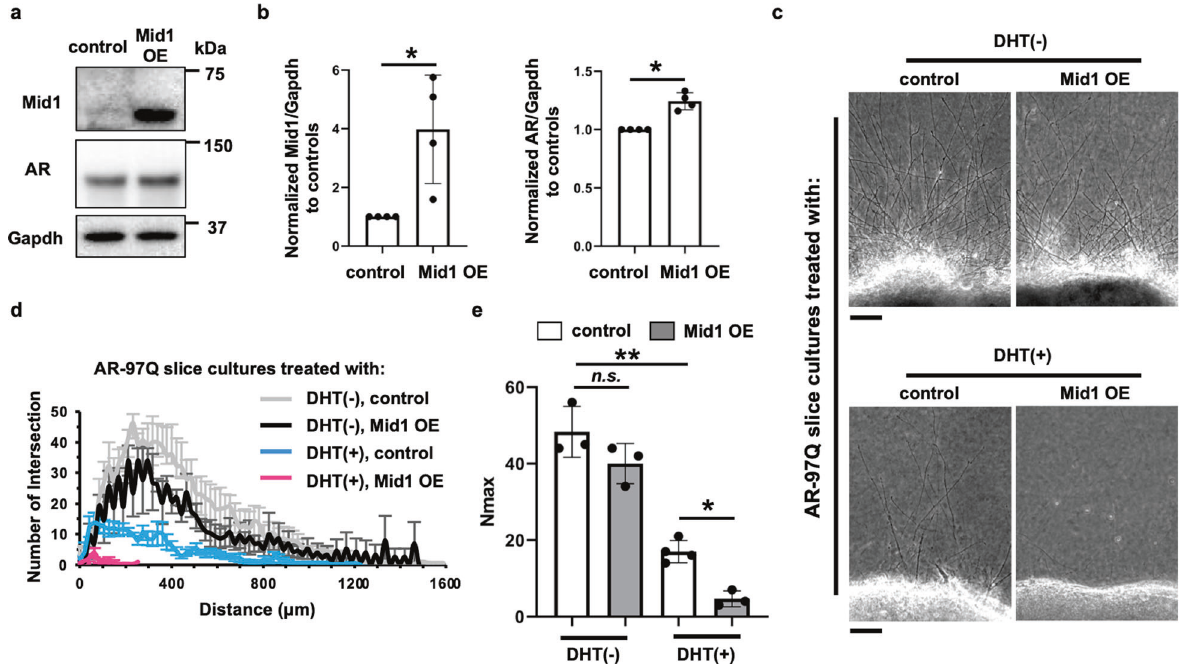
Fig. 6 Exacerbation of axonogenesis impairment by Mid1 overexpression in SBMA. a Immunoblots showing levels of Mid1, human AR, and Gapdh. b Quantitative densitometry analyses of Mid1 and human AR levels in a ( n = 4 samples per group). c Phase-contrast images showing the effects of Mid1 overexpression on the axonogenesis of the spinal cord slice culture from AR-97Q mouse fetus with or without DHT treatment. d For the spinal cord slice cultures from female AR-97Q female mouse fetus treated with DHT and overexpressed with GFP (control) or Mid1, plots showing the quanti fi cation of the intersection pro fi le was obtained by Neurite-J. e Comparisons of the maximal number of axons detected in an image ( N max ). Statistically signi fi cant difference (* p < 0.05, ** p < 0.001) was detected by Tukey ’ s multiple comparisons